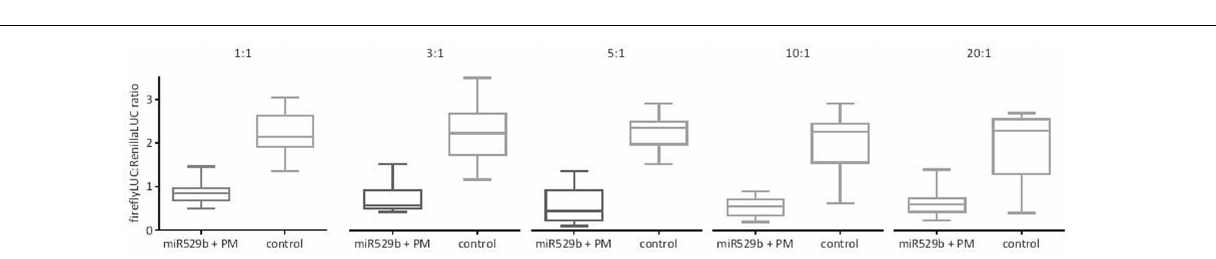
variability. The dual LUC plasmid pGrDL_SPb was used in